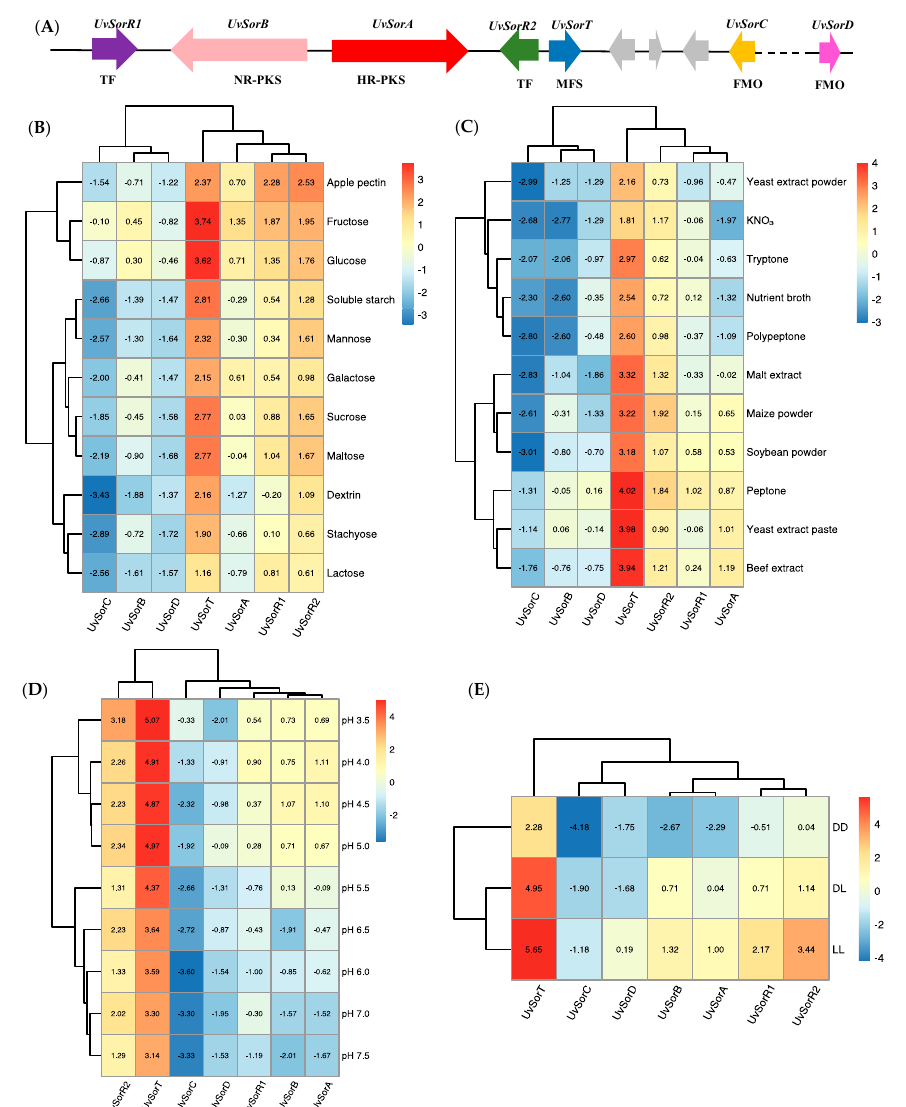
Figure 5. Heatmap based on the RT–qPCR analysis of the relative transcript levels of sorbicillinoid biosynthesis genes under different carbon, nitrogen sources, ambient pH, and light exposure. Relative transcript abundance was normalized to the level of β -tubulin with the 2 − ∆∆ Ct method. Numbers in the heatmap correspond to the log2 of fold change (FC) values of each gene, with UvSorA in the reference group (maltose, malt extract, pH 5.5 and DL treatment, respectively). Color scheme goes from red for upregulated genes to blue for down-regulated genes, when compared with the UvSorA gene in the reference group. ( A ) Schematic diagram of sor BGC. TF, transcription factor; NR-PKS, non-reducing polyketide synthase; HR-PKS, highly reducing polyketide synthase; MFS, major facilitator superfamily transporter; FMO, flavin-dependent monooxygenase; ( B ) The correlation heatmap between carbon sources and relative transcript level of sorbicillinoid biosynthesis genes; ( C ) The correlation heatmap between nitrogen sources and relative transcript level of sorbicillinoid biosynthesis genes; ( D ) The correlation heatmap between ambient pH and relative transcript level of sorbicillinoid biosynthesis genes; ( E ) The correlation heatmap between different light exposure treatments and relative transcript level of sorbicillinoid biosynthesis